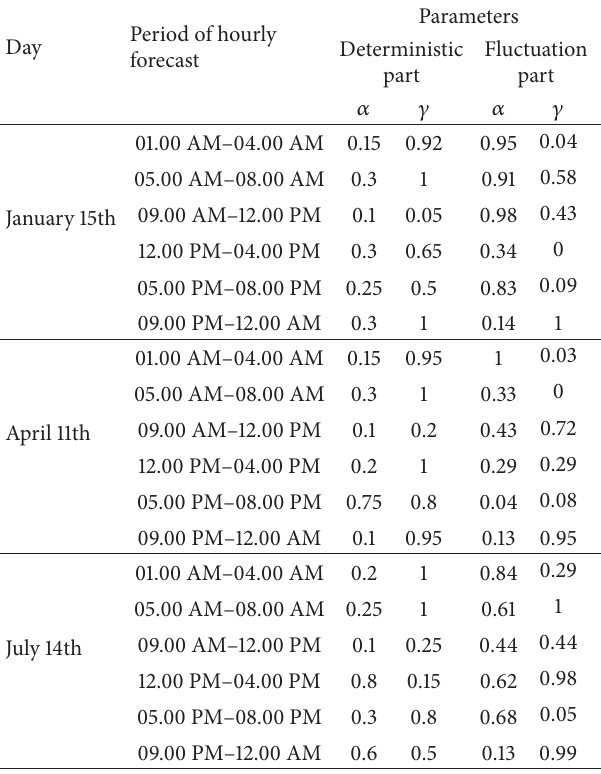
Table 3: Forecasting accuracy metrics for 4-hr-ahead